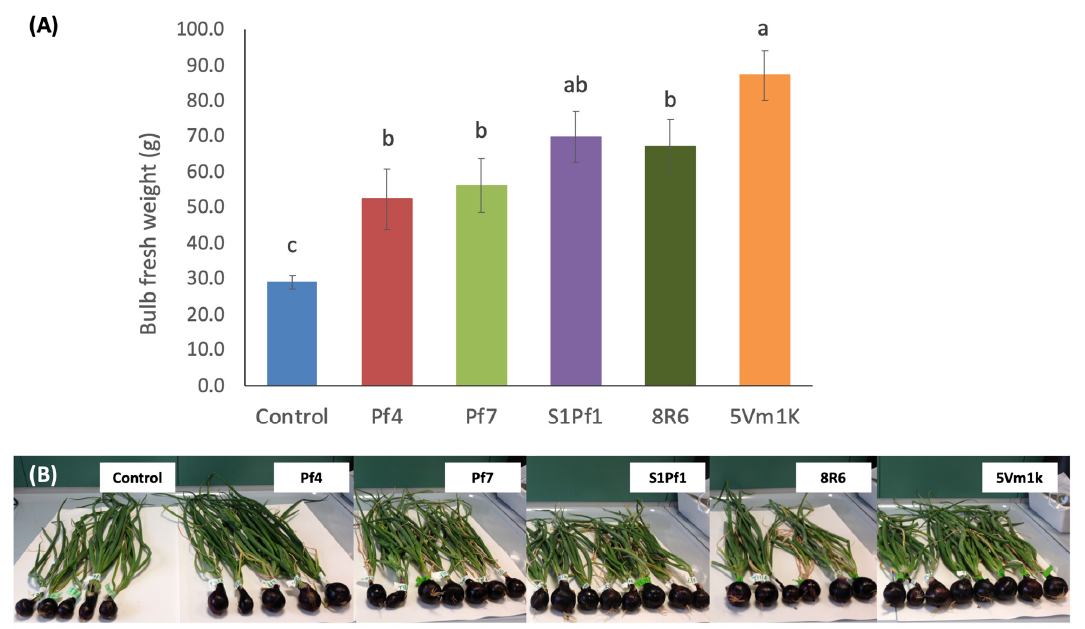
Figure 1. Effects of the five PGPB strains on onion bulb weight ( A ) and growth ( B ). Different letters on the bars in the histogram indicate significant differences among the treatments according to ANOVA followed by the LSD Fisher’s test ( p < 0.05). Table 3. Morphometric parameters of the bulb of Allium cepa inoculated or not (Control) with different bacterial strains ( Pseudomonas fluorescens Pf4, P. protegens Pf7, P. putida S1Pf1, P. migulae 8R6, Pseudomonas sp. 5Vm1K). Mean value ± standard error. Different letters in the row indicate significant differences among the treatments according to ANOVA followed by LSD Fisher’s test ( p < 0.05).